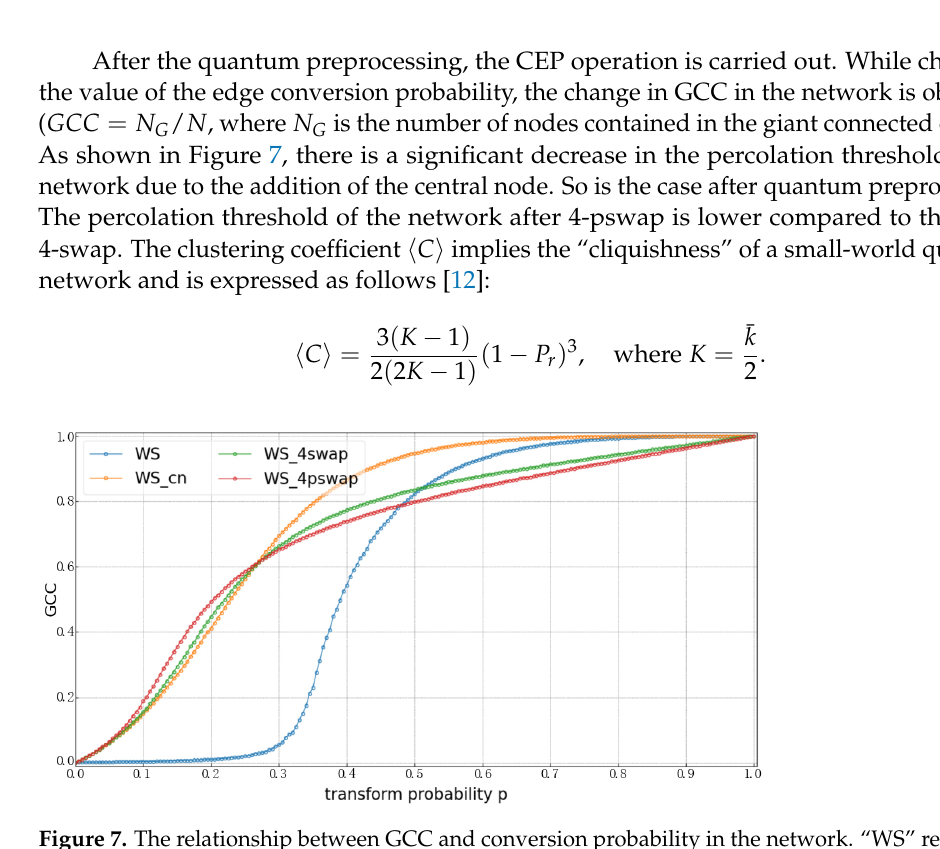
Figure 7. The relationship between GCC and conversion probability in the network. “WS” represents the percolation result in original WS network. “ WS cn ” represents the result of CEP after adding the central node. “ WS 4 swap ” and “ WS 4 pswap ” represent the percolation result in networks with the central node after 4-swap and 4-pswap, respectively.